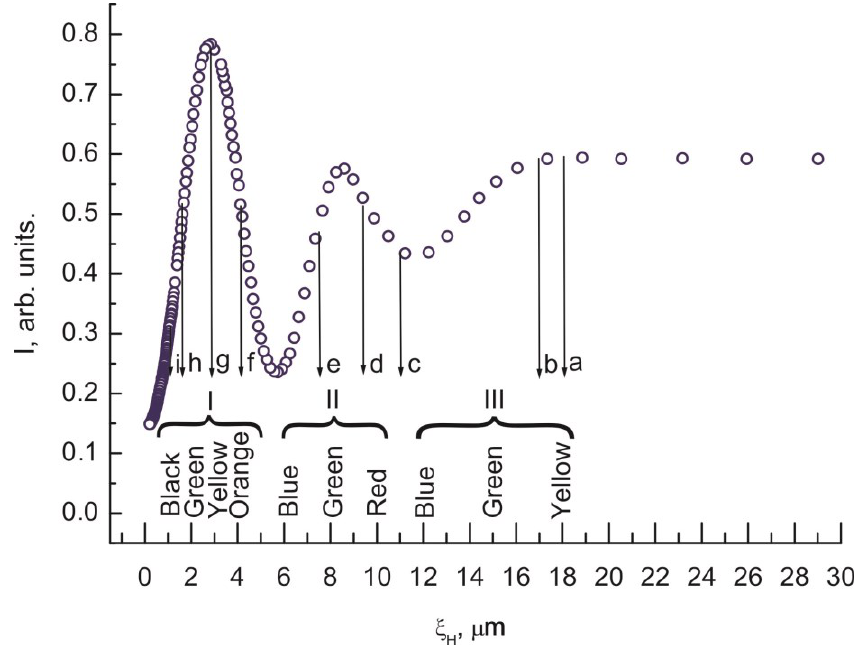
Figure 9. Dependence of intensity I of white light passed through the 30 µm thick planar 5CB layer with domains formed on the PC surface versus magnetic coherence length ξ obtained using Figure 2. Indices a–i correspond to Figure 1a,i. Designations black–yellow in the ξ scale correspond to the color sequence in the spectra of orders I–III obtained in an H external magnetic field in the planar LC layer in the cell with glass